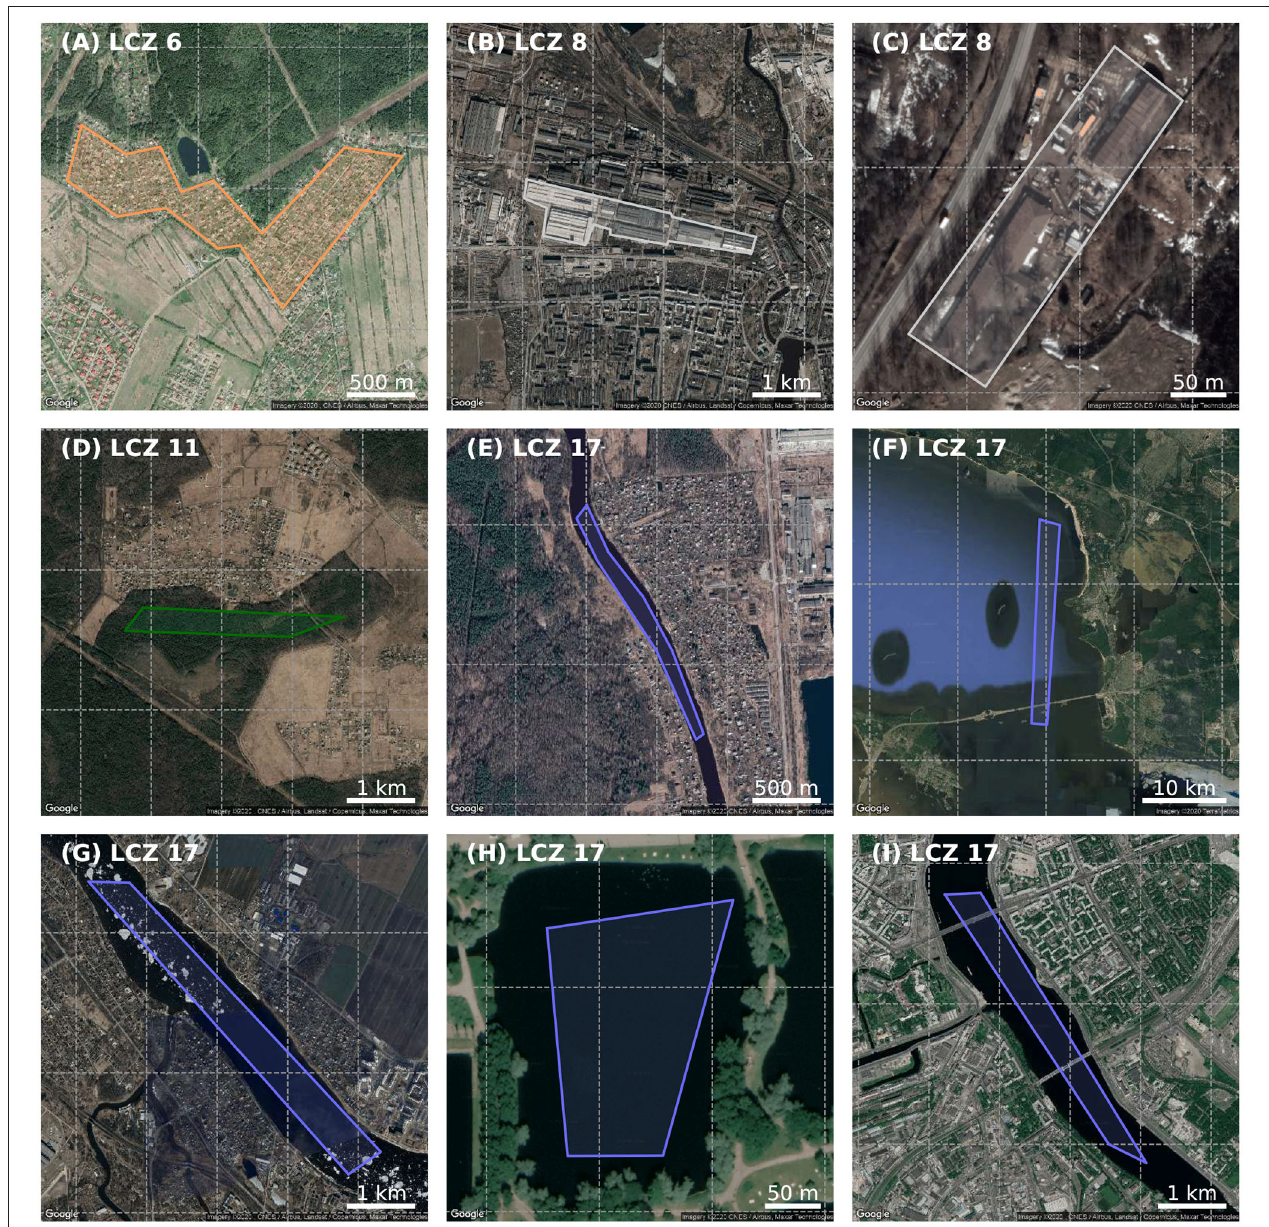
FIGURE 7 | All TA polygons tagged as suspicious during the first quality control step, for Saint Petersburg. Color scheme as in Figure 1 .